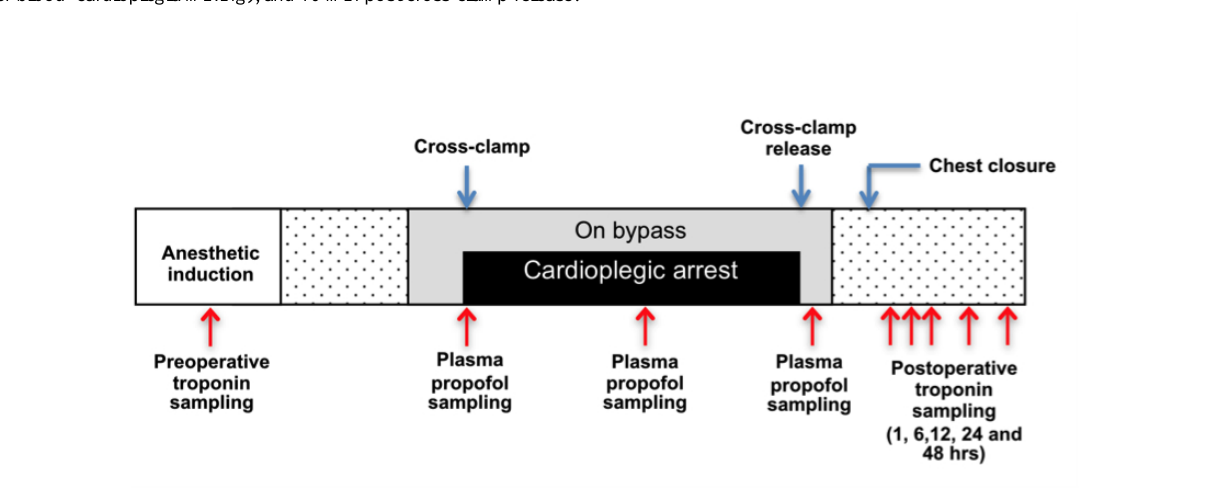
Figure 3. Measurement of myocardial injury and propofol concentration. The primary outcome is myocardial injury, assessed by measuring myocardial troponin T in serum from blood samples collected preoperatively and at 1, 6, 12, 24, and 48 hours after chest closure. The concentration of plasma propofol is measured in blood samples collected from the cardioplegia/bypass circuit immediately before aortic cross-clamping, once during cardioplegia (after blood–cardioplegia mixing), and 10 min post cross-clamp